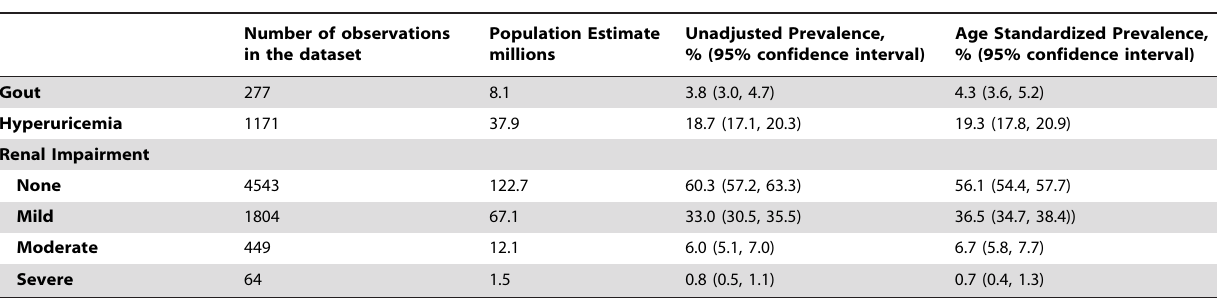
Table 3. Overall prevalence of gout, hyperuricemia and renal impairment in the NHANES 2009–10. a